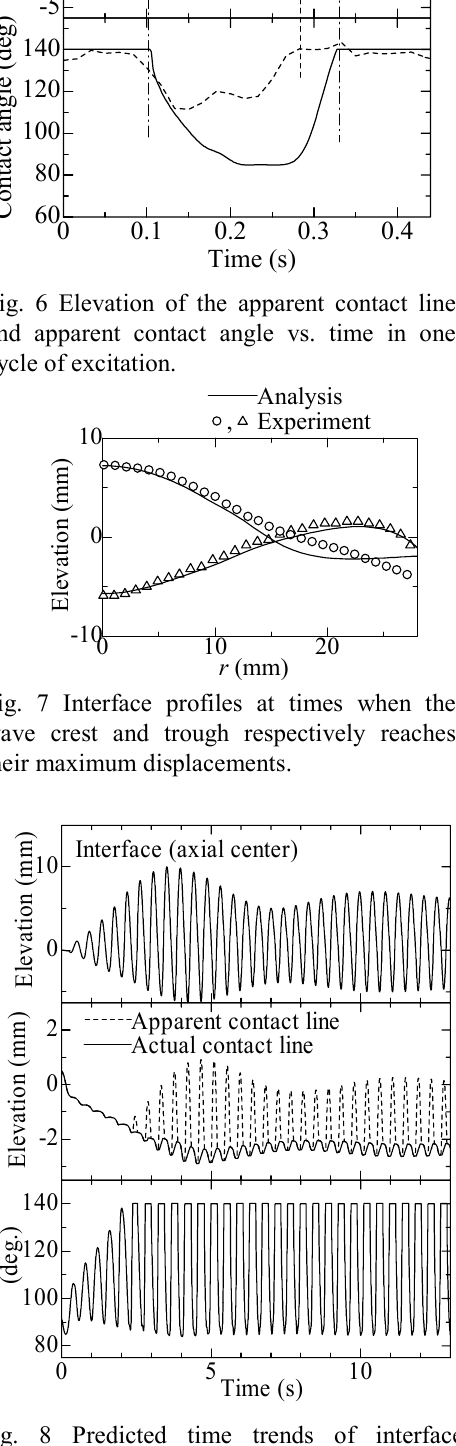
Fig. 8 Predicted time trends of interface elevation, contact line elevations and contact angle after start of